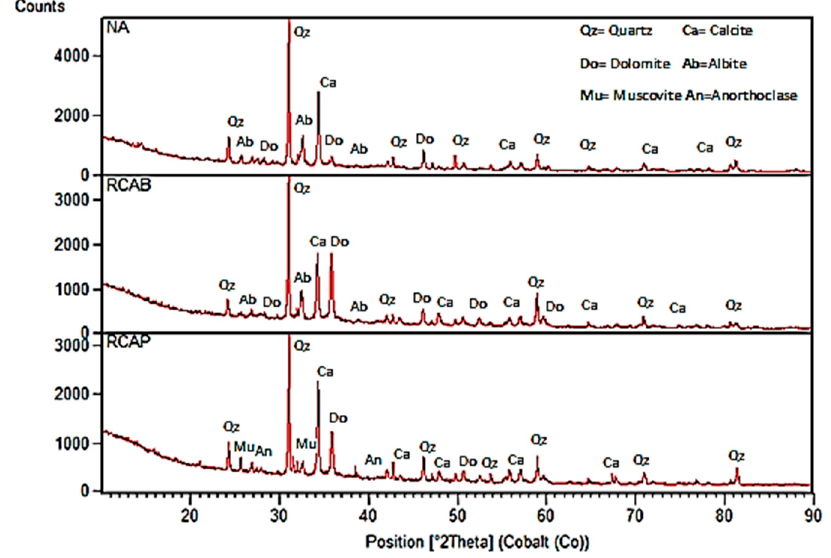
Figure 10. XRD patterns of NA, RCAP, and RCAB.